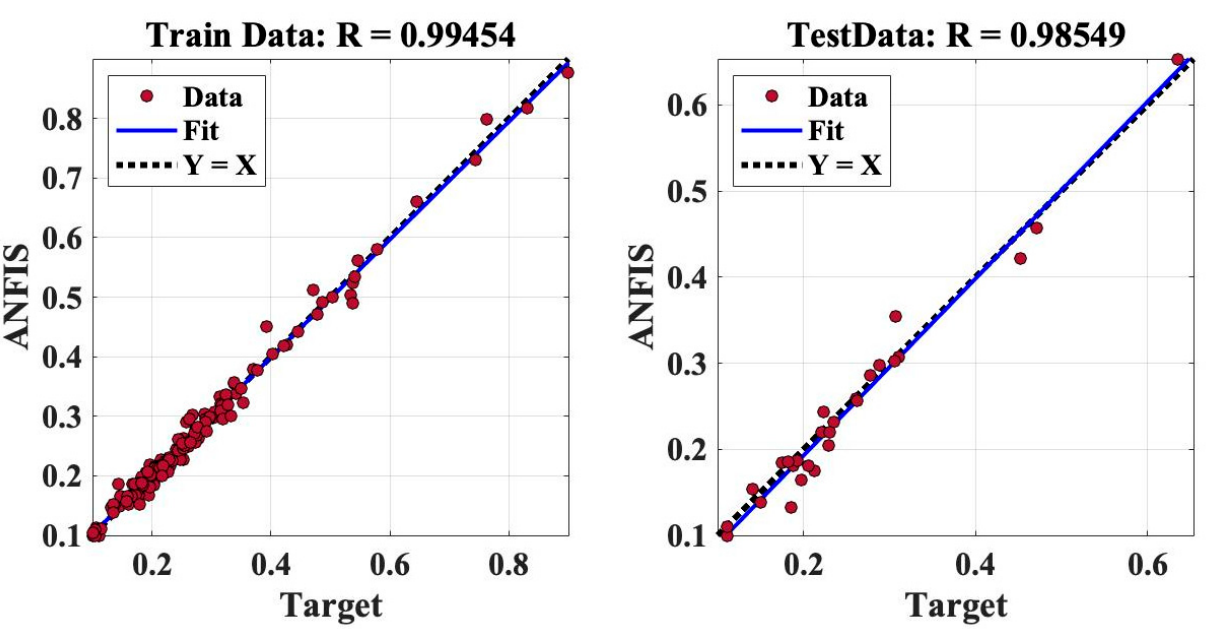
Figure 10. Regression plots for the training and testing datasets.